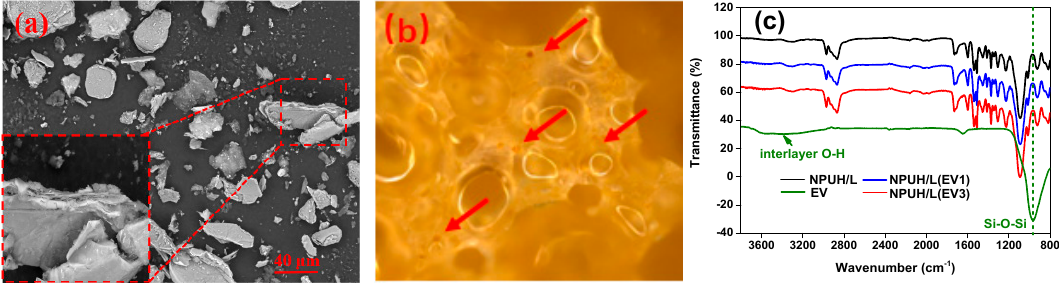
Figure 8. ( a ) Microstructure of EV fillers; ( b ) Photo of bionic composite with EV fillers; ( c ) spectra of bionic composites containing EV fillers.